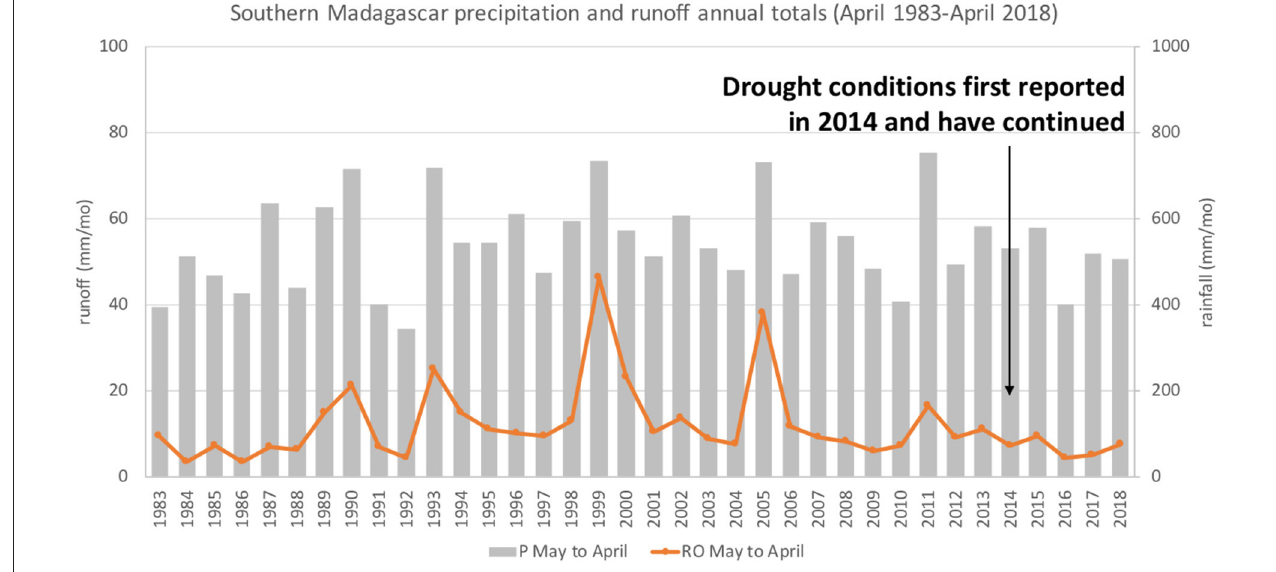
FIGURE 5 | Twelve-month precipitation and runoff spatially averaged over the Tsihombe basin, Southern Madagascar. 2016 was the second-worst year in the 35-year record. FEWS NET reports consecutive years of below average rainfall, and water availability deficits have reduced agricultural production and